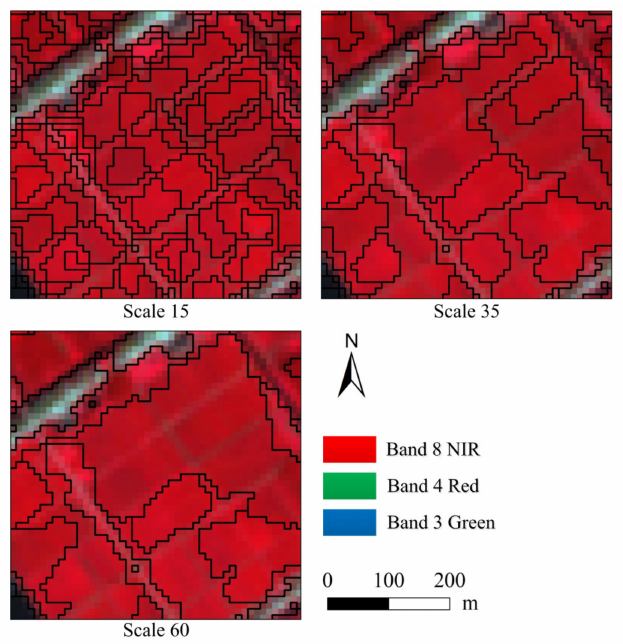
Figure 8. A demonstration of multi-scale segmentation results under different scale parameters. Shape and compactness are defined as 0.3 and 0.6